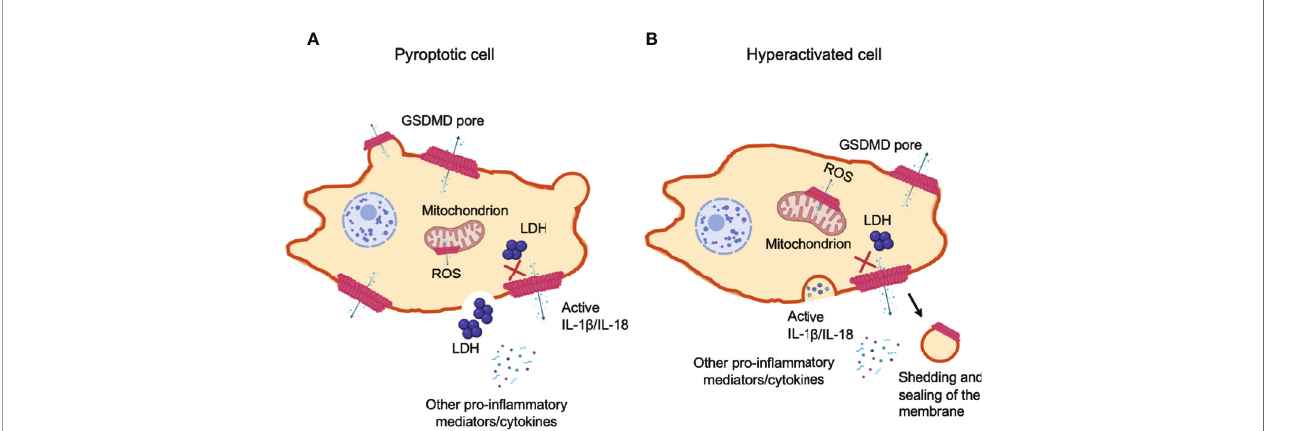
FIGURE 6 | Gasdermin D-mediated cell hyperactivation. Cell pyroptosis and IL-1 b secretion can be uncoupled under conditions of cell hyperactivation. This is a stage where phagocytes release IL-1 b while remaining intact. The cleaved GSDM-NT fragments can also bind to mitochondrial membranes with higher af fi nity. NT pore-forming fragments of both GSDMD and GSDME permeabilize the outer membrane of the mitochondria, driving the generation of reactive oxygen species (ROS), loss of transmembrane potential and the release of cytochrome ( c ). (A) Pyroptotic cells form large balloon-like membrane structures and dying cells appear to fl atten as their cytoplasmic contents are released, which is followed by cell swelling and membrane rupture. (B) Hyperactivated and pyroptotic cells can be differentiated by measuring lactate dehydrogenase (LDH) release, as it is too large to exit via GSDMD-NT pores and fully dependent on cell lysis for its release. Hyperactivated cells might have the capability to repair GSDMD pores through shedding of the disrupted membrane to recover damaged area. However, the mechanism to determine if GSDMD pores trigger cell pyroptosis or hyperactivation remains